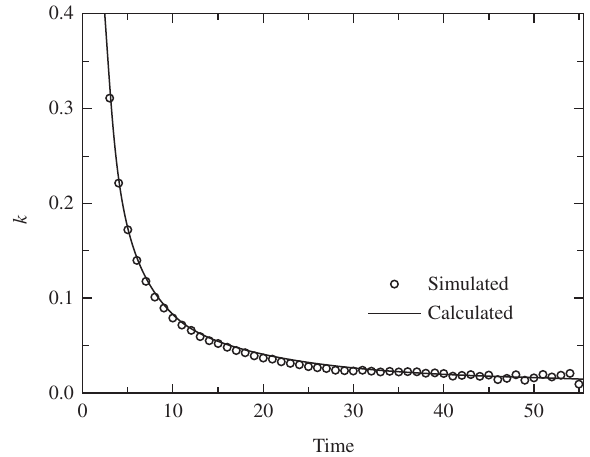
Figure 4. Average curvature of the interface between transformed and , against Area fraction, A . untransformed region, mobile interfaces, per unit of area, k , against time. A A Simulation results are in agreement with those calculated from the kinetics of a single grain, Equation